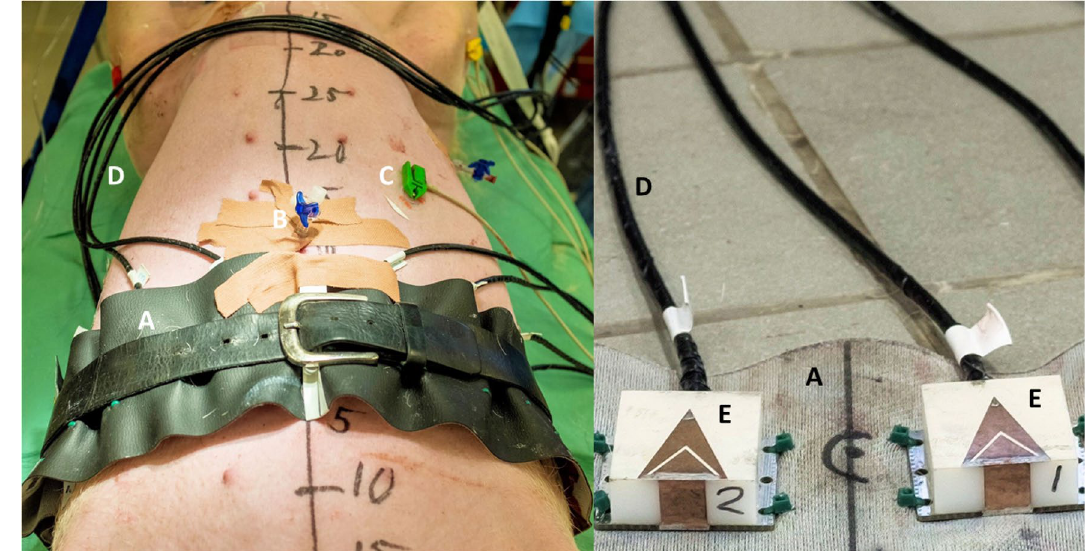
Figure 7. Experimental study setup. Left) Porcine model with a microwave belt ( A ) around the abdomen, the inserted catheter into the intraperitoneal cavity ( B ), ECG cable ( C ), and microwave cables ( D ). Right) Image of two of the microwave antennas ( E ) can be seen on the inside of the microwave belt ( A ).